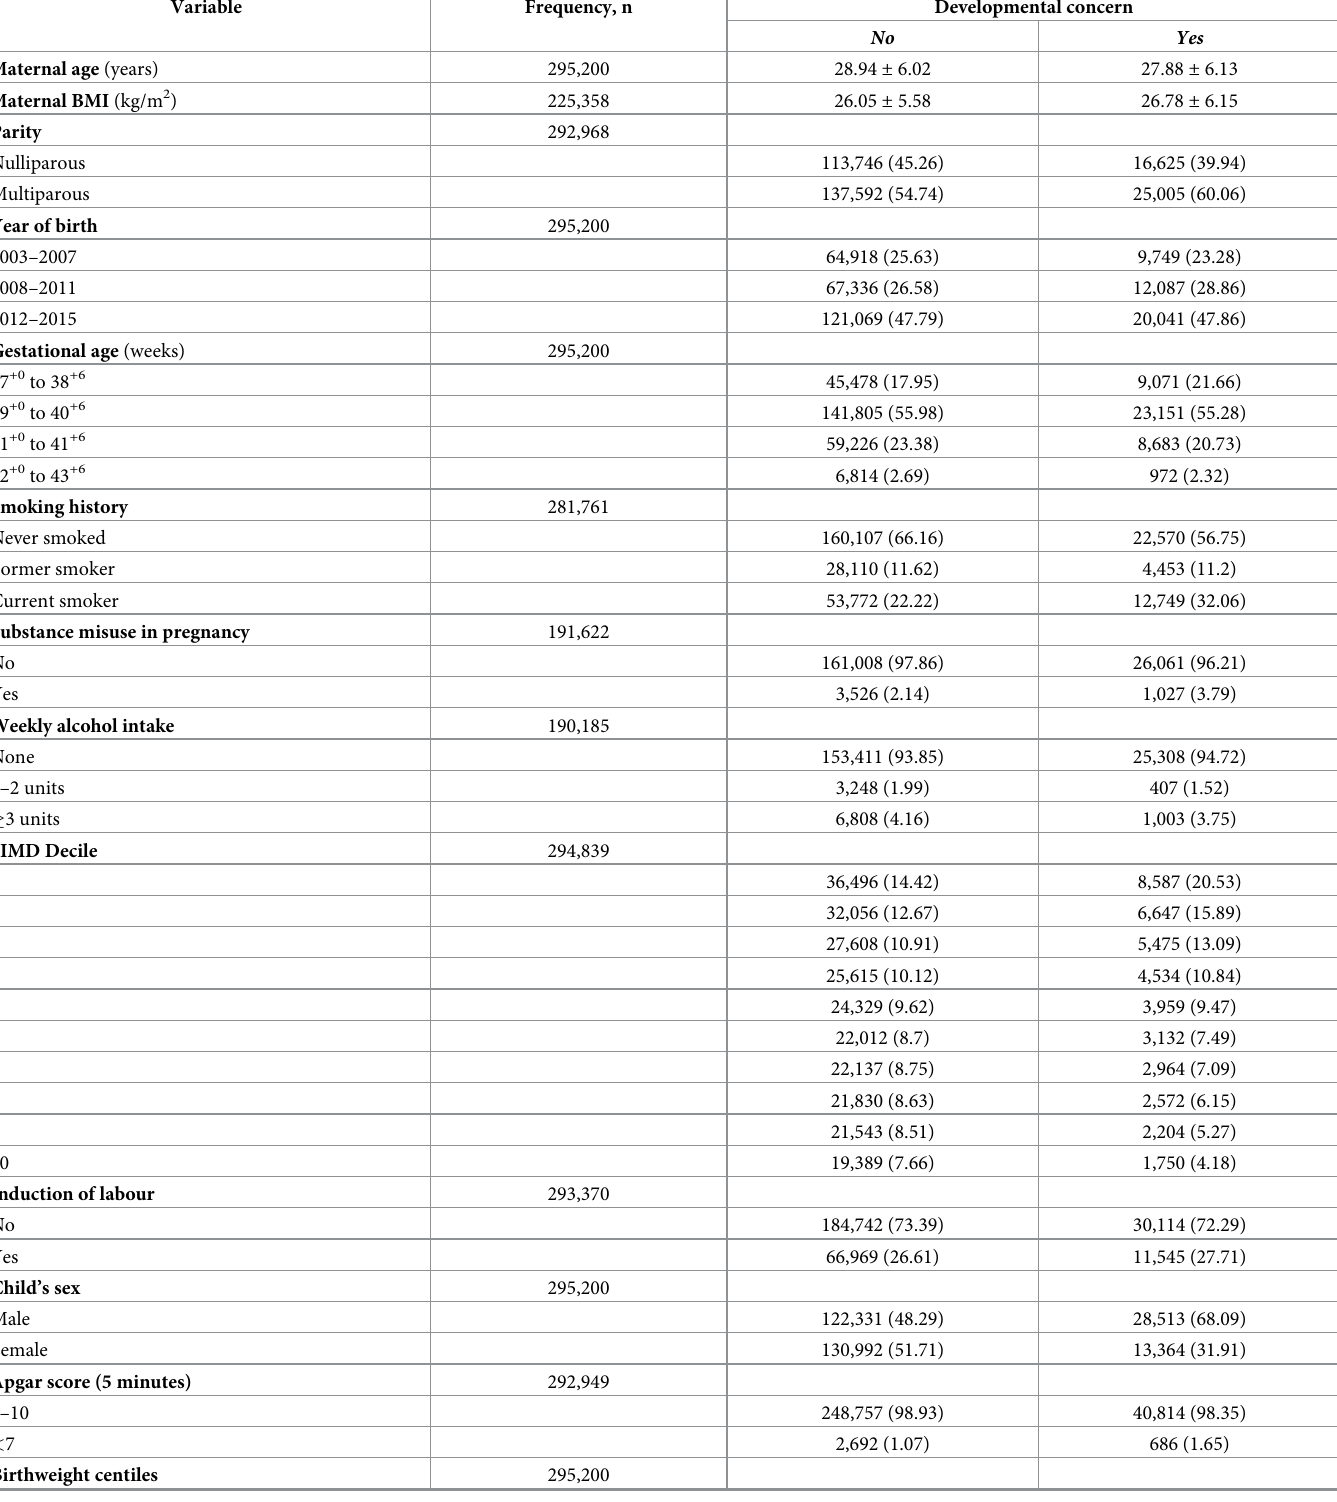
Table 1. Basic maternal and child characteristics of infants with complete follow-up data by developmental